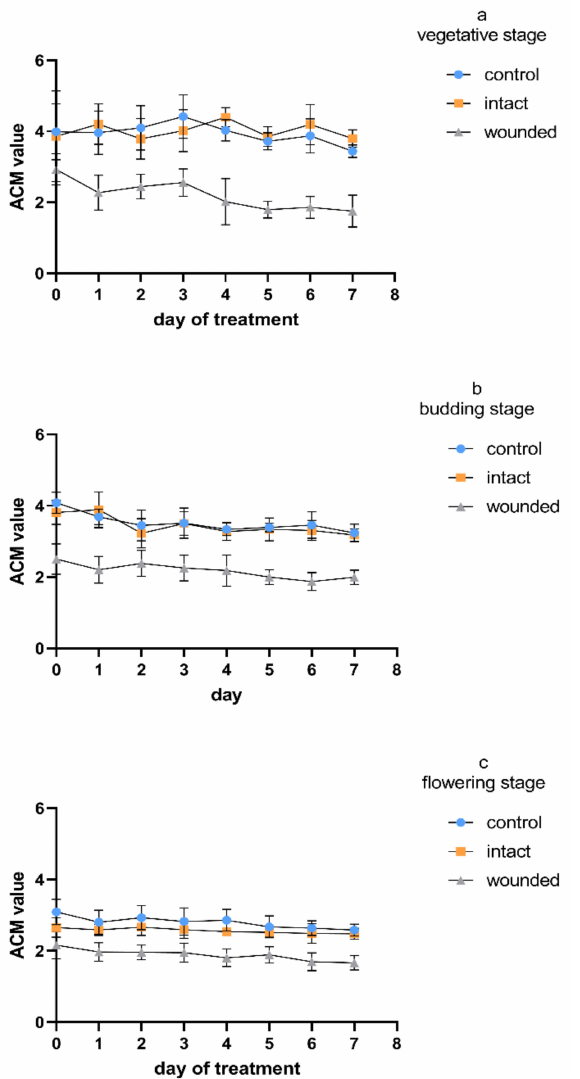
Figure 6. Anthocyanin content of Ocimum basilicum var. minimum L. versus leaf wounding imposed at the ( a ) vegetative, ( b ) budding, or ( c ) flowering stage. Data are means ( n = 21) ± standard deviation